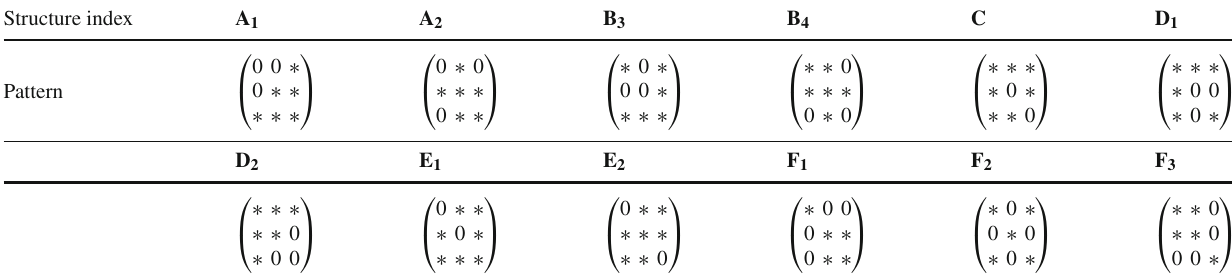
Table 3 The list of the structural patterns of the two-zero minor and texture structure. We follow the notation in [75,76] Structure index A